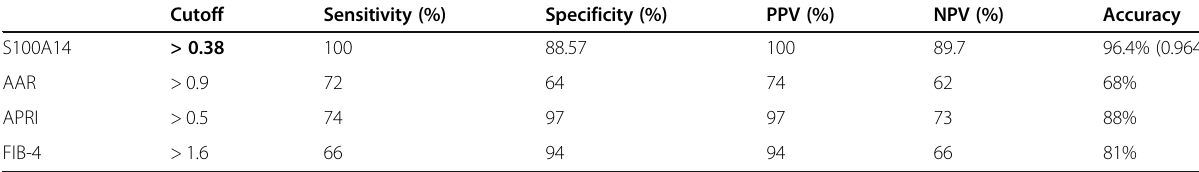
Table 3 The sensitivity and specificity for S100A14, AAR, APRI, and FIB-4